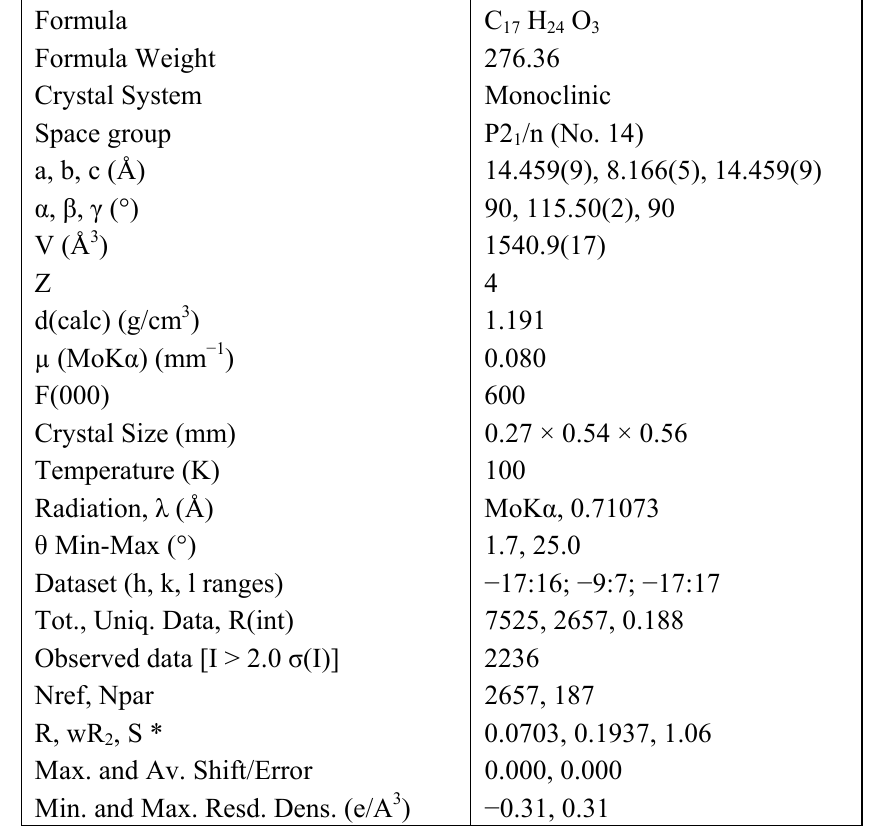
Table 3. Crystal Data and Details of the Structure Determination for Compound 3